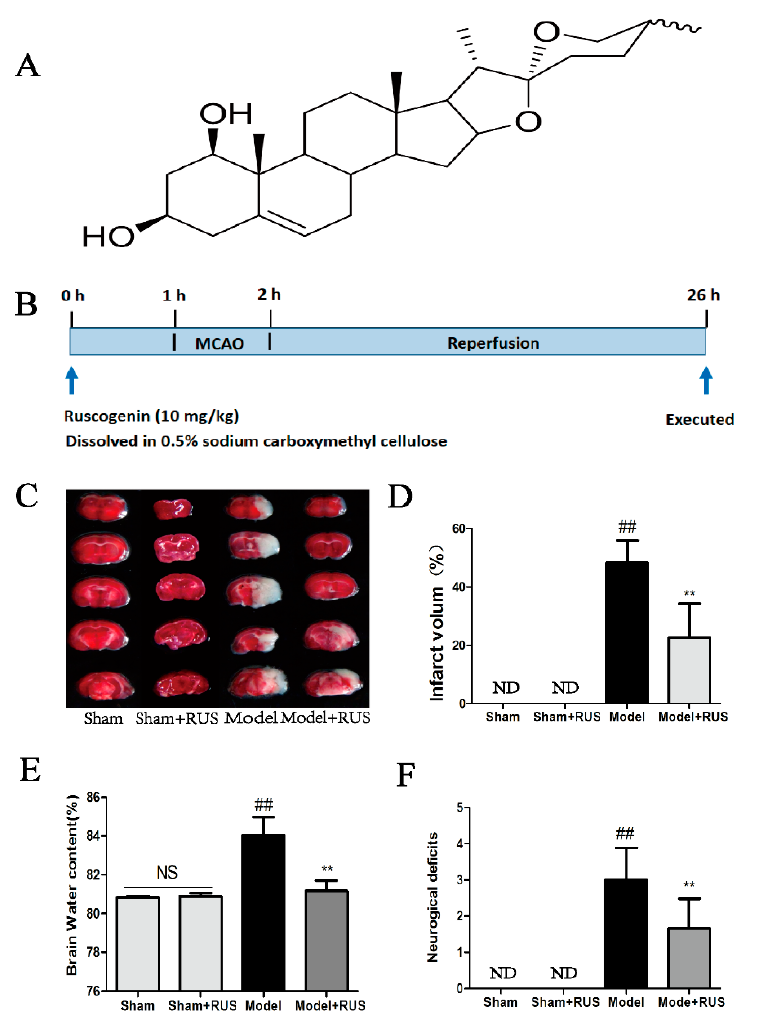
Figure 1. Effects of ruscogeinin on brain tissue injury in mice following MCAO/R. ( A ) The chemical structure of ruscogenin; ( B ) schematic diagram showing the experimental protocol. The experimental groups included the Sham group, Sham + RUS (ruscogenin) group, Model (MCAO/R) group and Model + RUS group. Ruscogenin was administrated intragastrically 1 h before occlusion, and the mice were reperfused after MCAO 1 h and sacrificed after a further 24 h, respectively; ( C , D ) representative of TTC-stained brain sections and quantitative analysis of infarct volume in different groups; ( E , F ) quantitation of brain water contents and neurological deficits scores in different groups. ND means “not detected”. NS means “not significant”. The data ( n = 6) are expressed as means ± SD. ## p < 0.01 vs. Sham, ** p < 0.01 vs. Model.